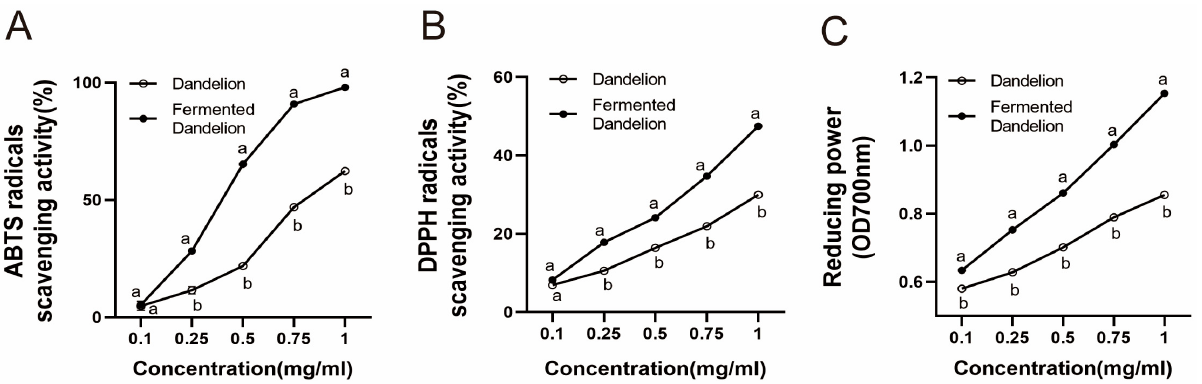
Figure 1. Determination of the antioxidant activity of dandelion and fermented dandelion. ( A ) ABTS radical scavenging rate. ( B ) DPPH radical scavenging rate. ( C ) Determination of reducing power. The data are expressed as mean ± SD (n = 3). Di ff erent lowercase le tt ers indicate statistically signi fi - cant di ff erences ( p < 0.05) between the groups.